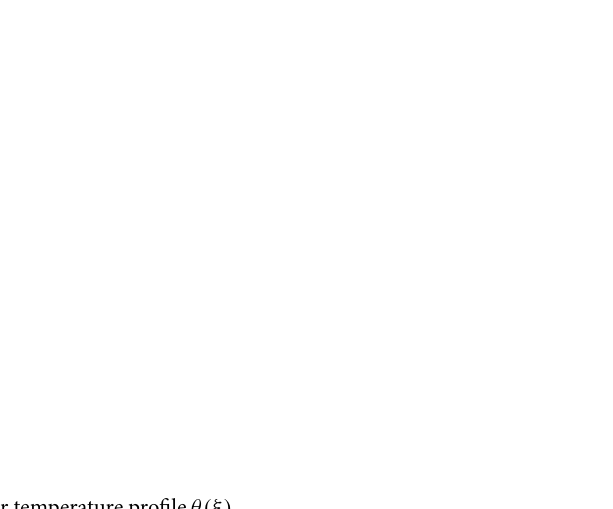
Table 2. Impact of merging parameters over temperature profile θ(ξ) .